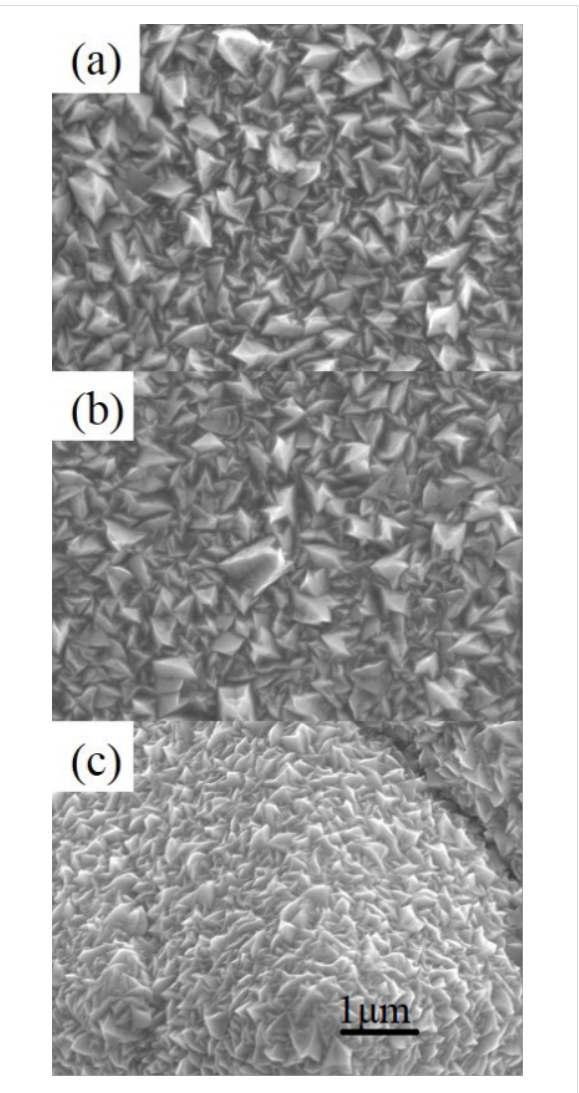
Figure 3: SEM images of the samples (a) ZnO p(100) , (b) ZnO p(111) , and (c) ZnO t(100) .